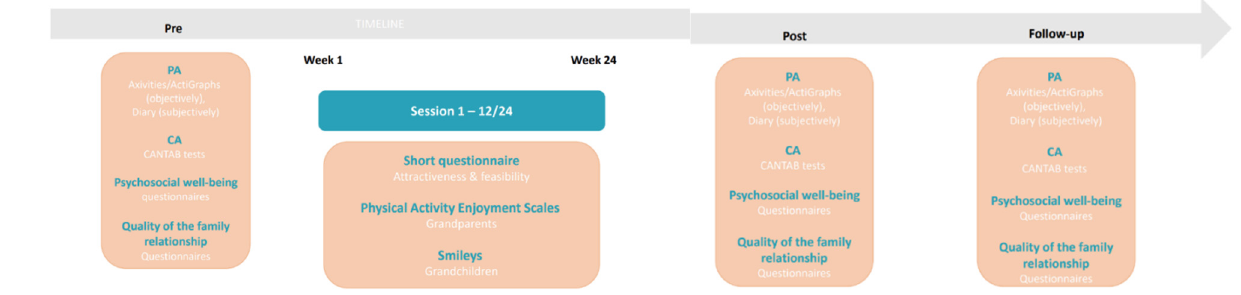
Figure 5. Overview of the RCT with the pre- (baseline), post- (after 24 weeks) and follow-up (after 36 weeks) measurements.